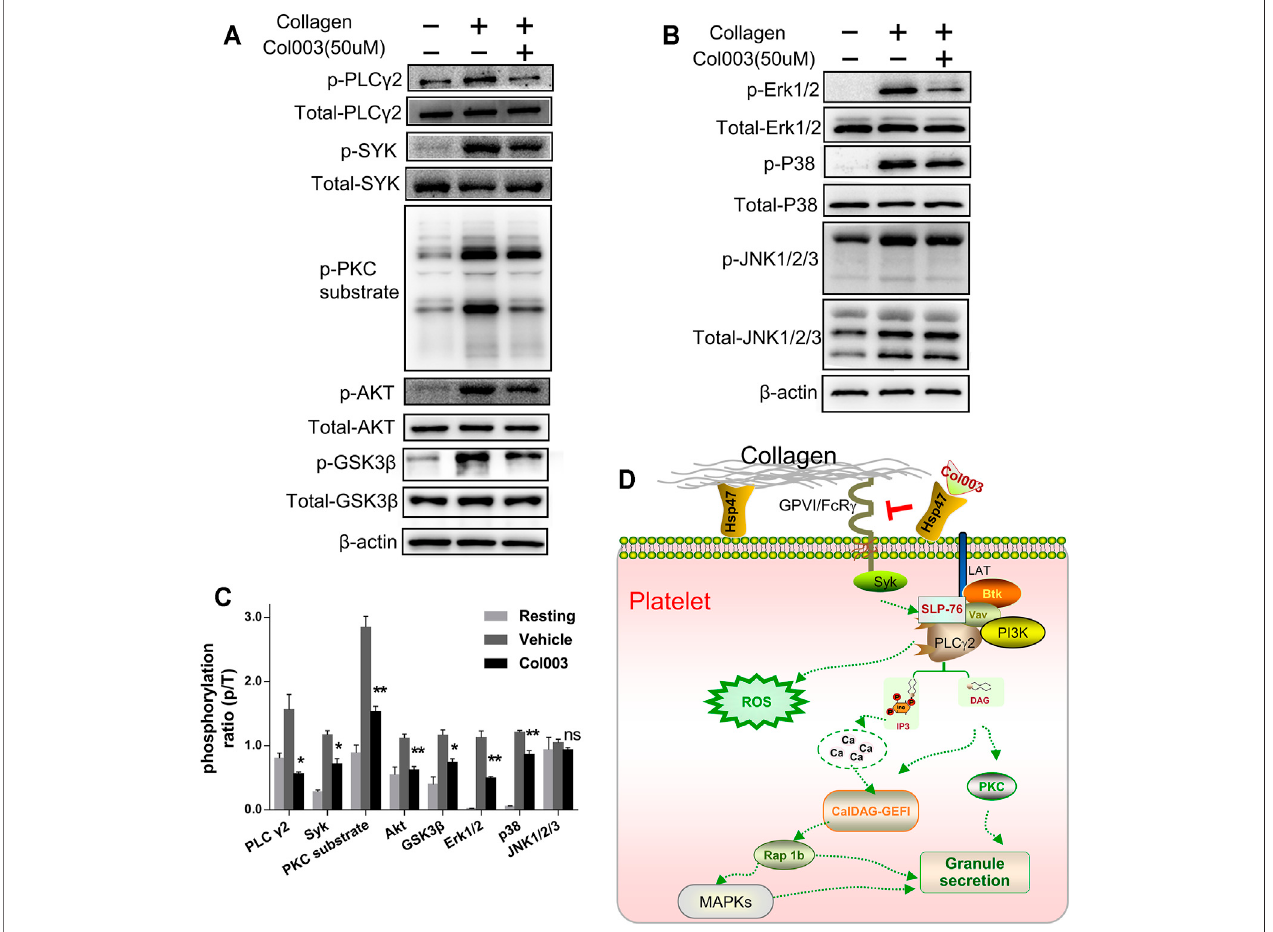
FIGURE 4 | Col003 inhibits collagen-induced phosphorylation of signaling molecules. (A) Col003 inhibits phosphorylation of the GPVI signaling pathway induced by collagen. (B) Col003 attenuated collagen-activated platelet p38 and ERK2 phosphorylation. (C) The values shown in the bar graphs are representative of three independent experiments. Statistical analysis was performed with unpaired two-tailed Student ’ s t -test. * p < 0.05 and ** p < 0.01 (vs vehicle). (D) Schematic representation of the signaling pathways may be involved in the antiplatelet effect of Col003 induced by collagen.